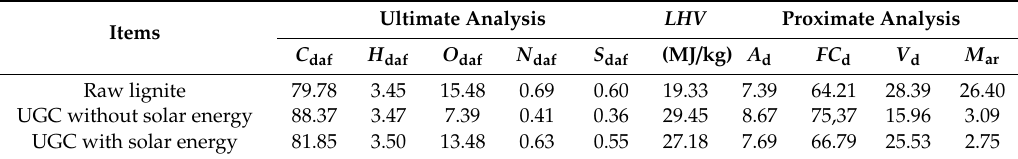
Table 13. Ultimate and proximate analyses data of three di ff erent coals.